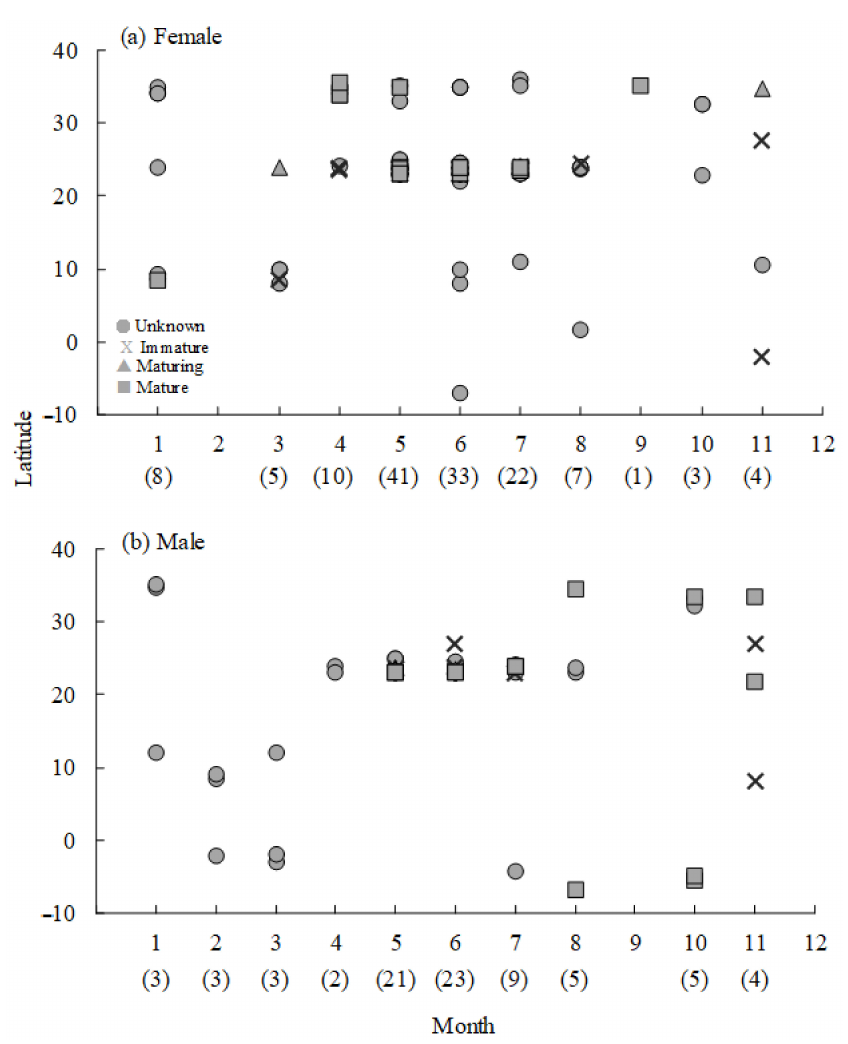
Figure 5. Total length–weight relationship of M. pelagios .